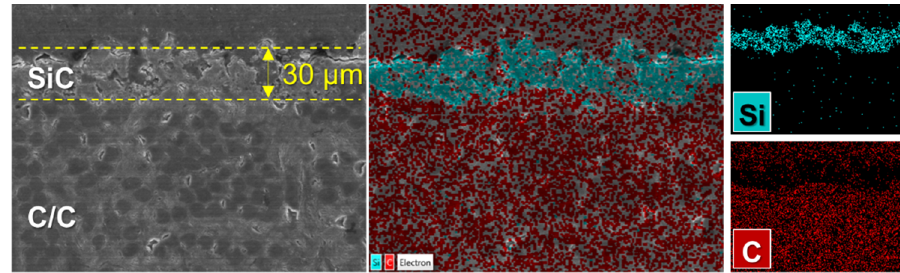
Figure 2. Cross-sectional field emission-scanning electron microscope (FE-SEM) image and energy dispersive spectrometer (EDS) analysis results of the substrate.